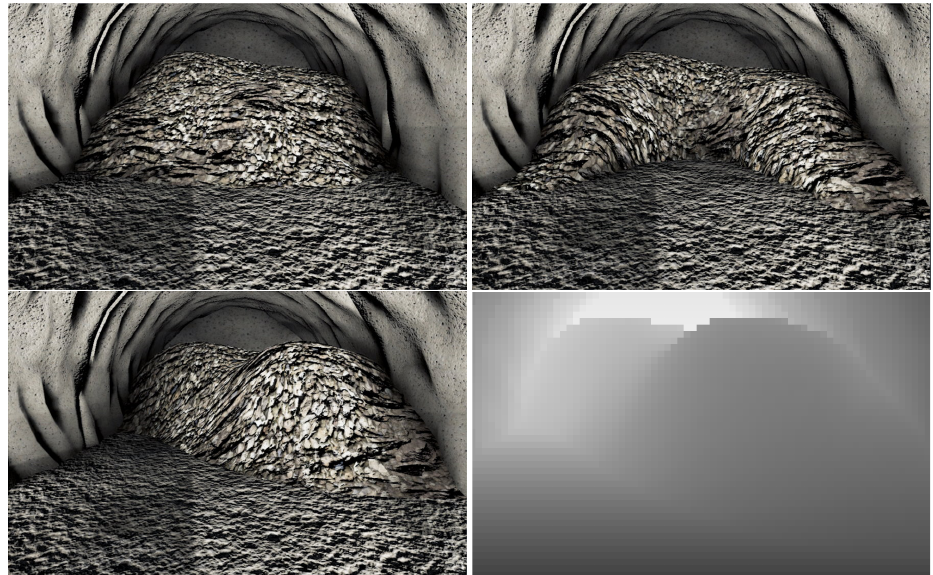
Figure 2. Sample camera images of the initial piles, referred to as convex ( upper left ), concave ( upper right ), and right-skewed ( lower left ); they are also shown in the depth camera view in the ( lower right )